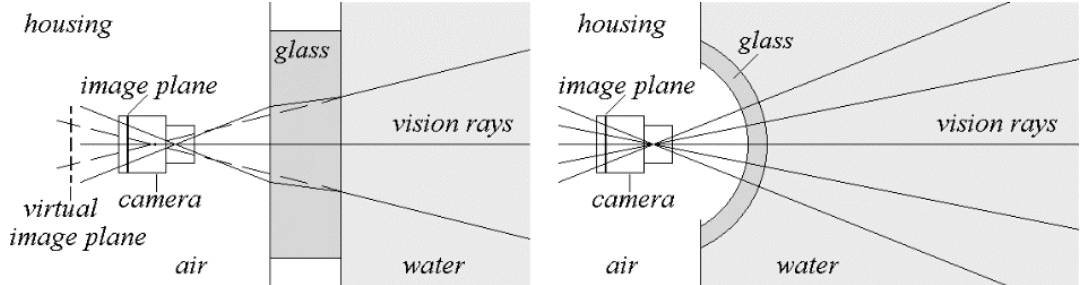
Figure 1. Geometry of rays in case of plane glasses ( left ) and spherical dome ports ( right ).